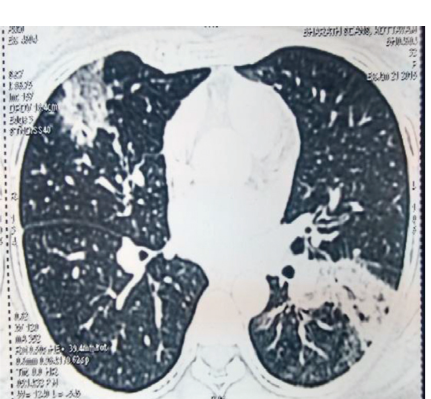
Figure 3: HRCT chest showing peripherally based patchy, sub- segmental lesions of the upper lobe and left lower